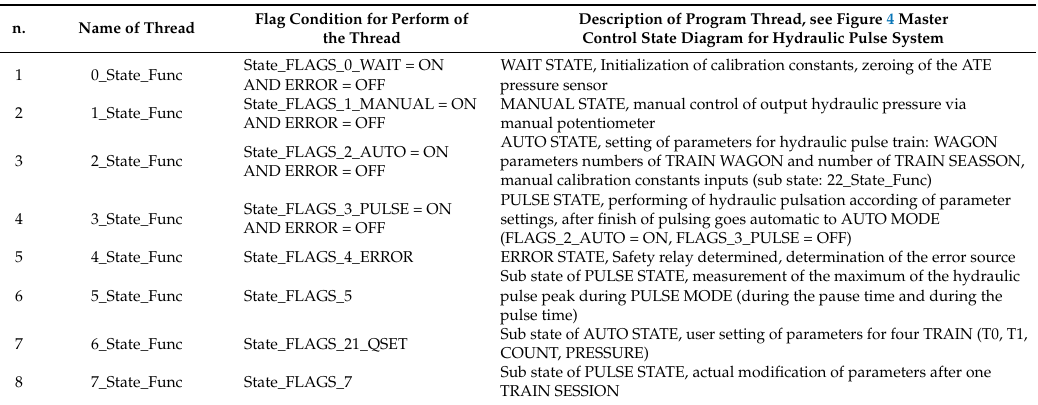
Table 3. List of application layer